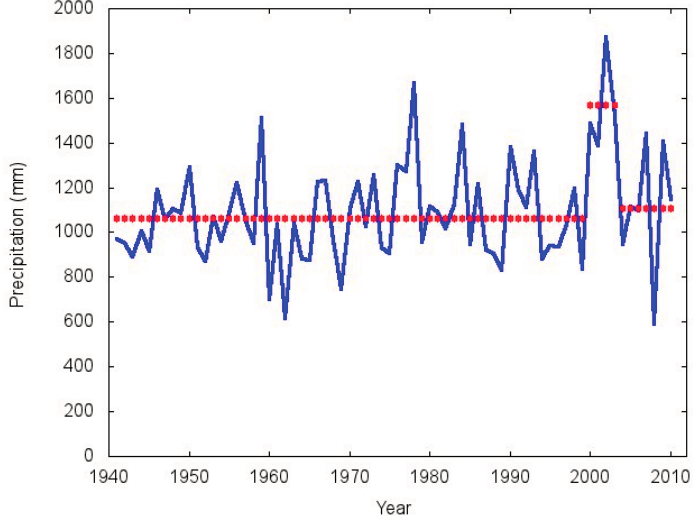
Figure 6. Annual precipitation and means for sub-periods in the Mesopotamian Pampa sub region by Hubert’s segmentation